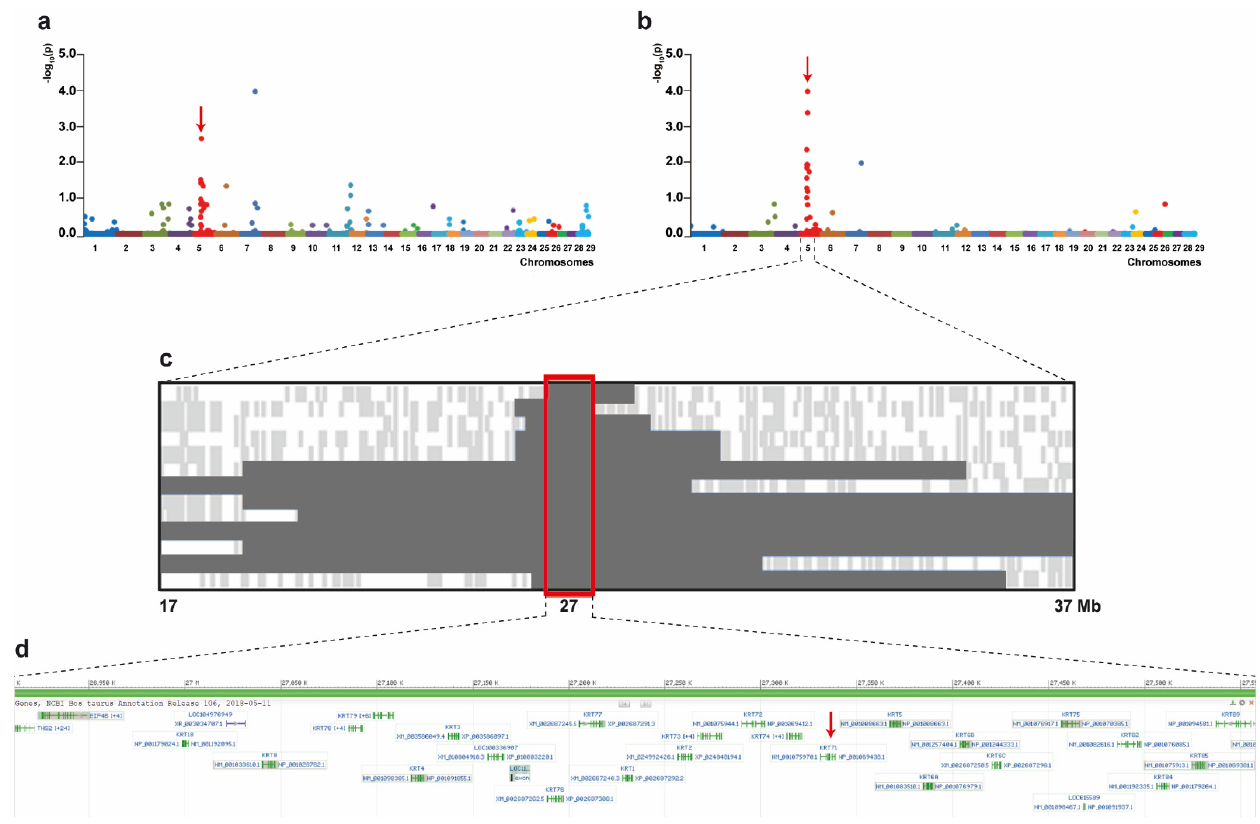
Figure 3. Positional cloning of the locus for recessive congenital hypotrichosis (HY) in Hereford cattle. ( a ) GWAS case/control results considering all purported HY-suspicious calves. Each chromosome is color coded along the X axis. The Y axis represents the –Log 10 of the corrected empirical P-value (max(T)) after 10,000 permutations from PLINK. ( b ) GWAS case/control results excluding calves from group C. Each chromosome is color coded along the X axis. The Y axis represents the –Log 10 of the corrected empirical P-value (max(T)) after 10,000 permutations from PLINK. ( c ) Schematic representing the genotypes of 13 HY-affected calves on chromosome 5. Each horizontal lane represents one calf with dark grey shading, indicating shared homozygosity. Light grey shading indicates a heterozygous genotype and white indicates an alternative homozygous genotype. The approximate Mb position is indicated below the figure. The red box encompasses the consensus homozygous region which spans approximately 690 kb. ( d ) Gene content of the critical region. Screen shot of NCBI Genome Data Viewer (ARS-UCD1.2 assembly, Bos taurus annotation release 106) shows the cluster of keratin II encoding genes including KRT71 (red arrow). Table 1. Association of the 8-bp deletion with the hypotrichosis